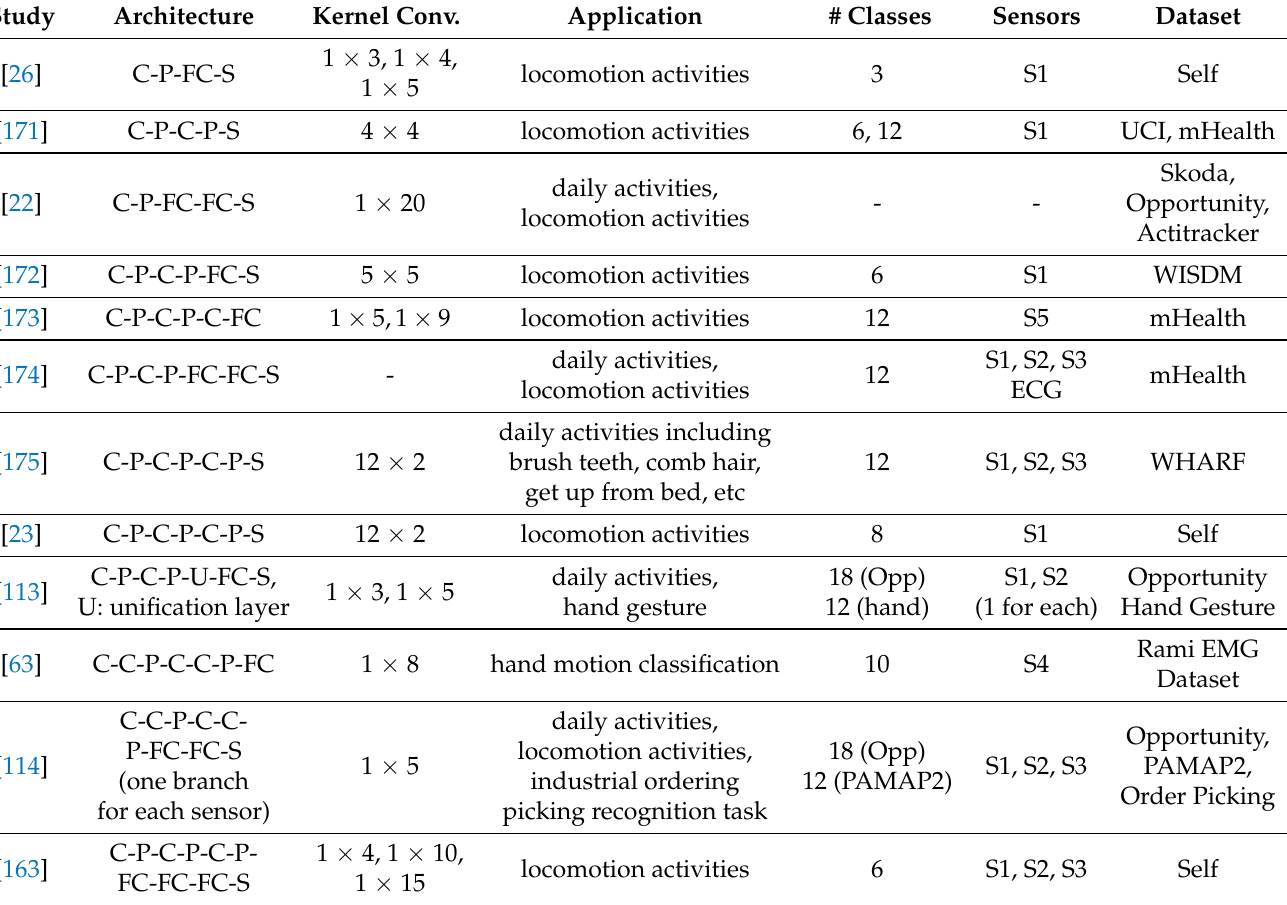
Table 2. Summary of typical studies that use layer-by-layer CNN structure in HAR and their configurations. We aim to present the relationship of CNN kernels, layers, and targeted problems (application and sensors). Key: C—convolutional layer; P—max-pooling layer; FC—fully connected layer; S—softmax; S1—accelerometer; S2—gyroscope; S3—magnetometer; S4—EMG;